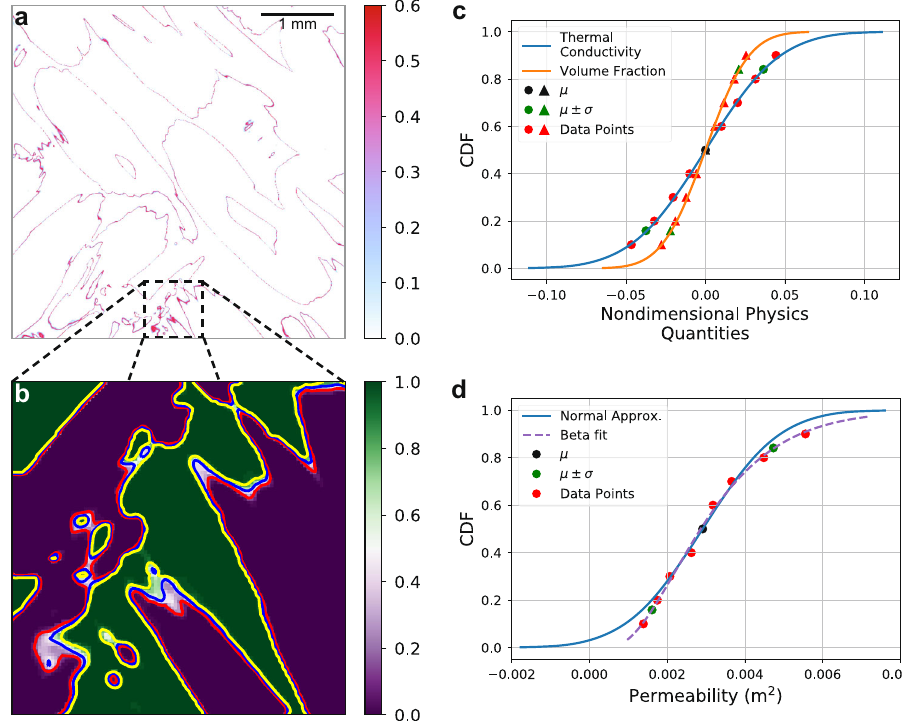
Fig. 3 Segmentation uncertainty in a woven composite material. a Graphical 2D representation of uncertainty, with the highest uncertainty occurring near material boundaries. b Visualization of the standard segmentation contours in a zoomed-in region of the probability map that uses the same slice plane shown in ( a ), where the red, blue, and yellow contours are the standard segmentations, μ − σ , μ , and μ + σ , respectively. c CDF for two physics quantities, thermal conductivity (circles) and volume fraction (triangles), highlighting that some physics quantities are more sensitive to segmentation uncertainty than others. d CDF of fl uid permeability, which exhibits a non-Normal distribution.